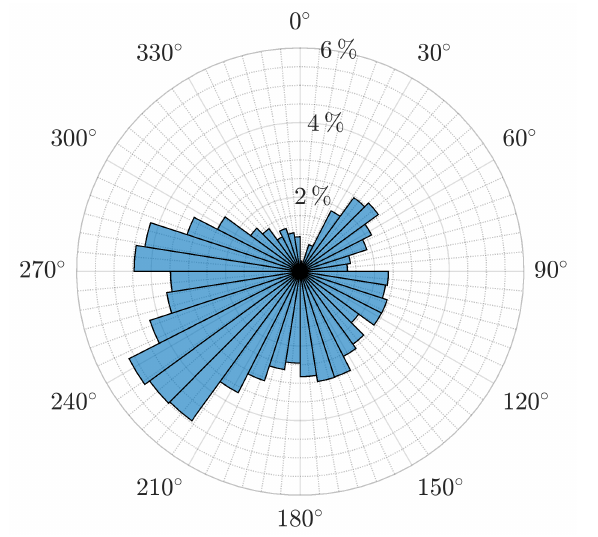
Figure 5. Wind rose of 1Hz measurement data recorded at a met. mast in Brusow, north-eastern